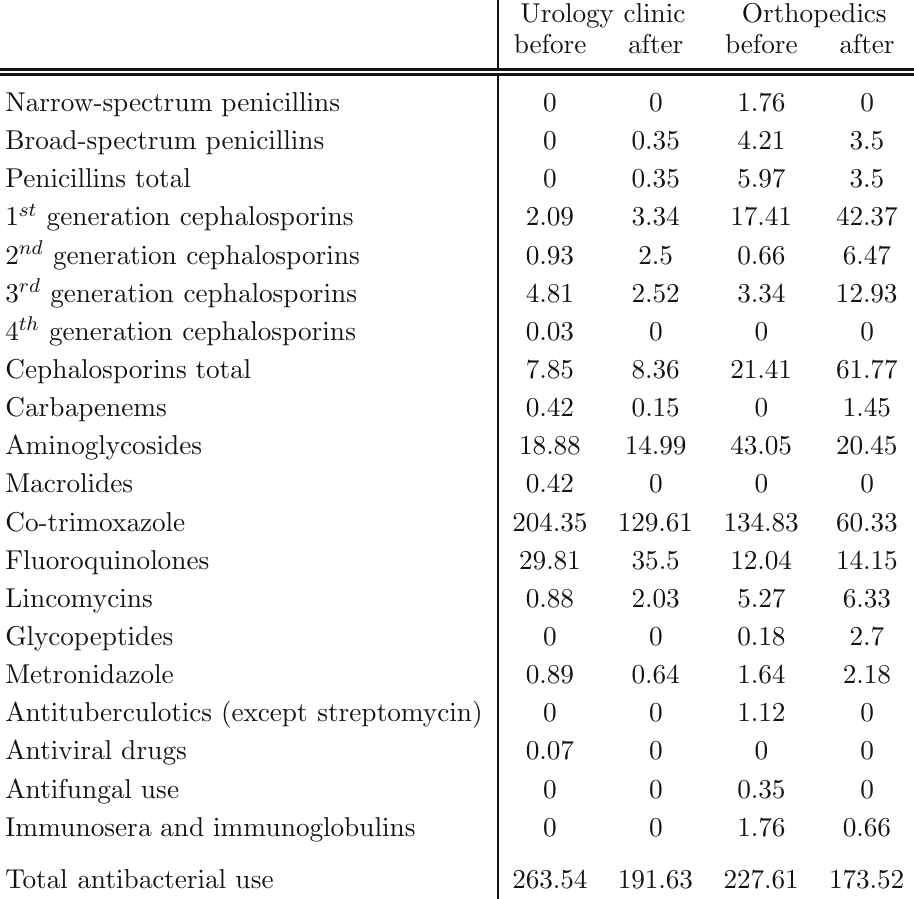
Table 3 Antibiotic use at the urology and orthopedic wards before and after implemen- tation of unit-dose drug distribution.